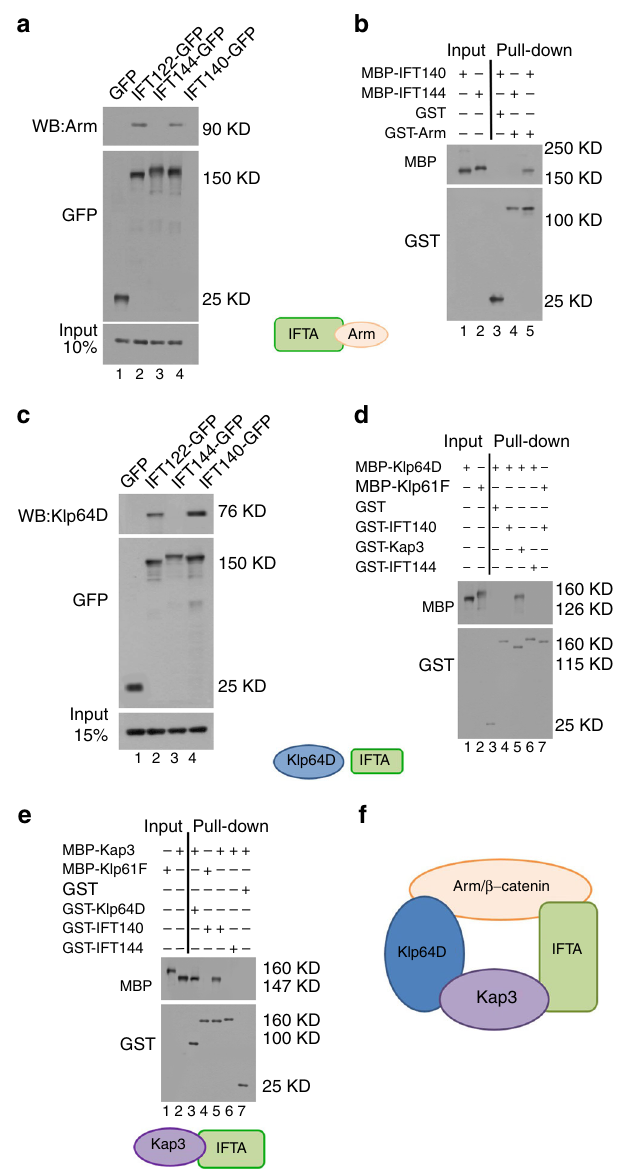
Fig. 3 Kinesin-2, IFT-A, and Arm/ β -catenin are physically associated. a , c Co-immunoprecipitation assay of IFT-A components with Klp64D or Arm from tub> IFT122GFP (lane 2) and tub > IFT140GFP (lane 4) or tub > IFT144 (as a negative control, lane 3) wing imaginal discs. Protein extracts from wing discs were immunoprecipitated (IPed) with anti-GFP. IPs and input (10 − 15% of wing disc lysates used in IP step) were analyzed by blotting with antibodies to Arm ( a ), or Klp64D ( c ). Note that IFT-A components (IFT122 and IFT140) associate with Arm/ β -catenin ( a ) and Klp64D ( c ). b Direct binding of IFT140 and Arm. Full-length IFT140 (lane 1: input 15%) was pulled down by GST-Arm (lane 5), IFT144 and GST alone are negative control (lanes 3, 4). d Klp64D is indirectly associated with IFT140. Full- length Klp64D (lane 1, 10% input) was not pulled down by GST (lane 3, negative control), or GST-IFT144 (lane 6, negative control), or GST-IFT140 (lane 4), but was pulled down by GST-Kap3 (lane 5; positive control). Full- length Klp61F (negative control; lane 2: 10% input) was not pulled down by GST-IFT140 (lane 7). e IFT140 directly binds to Kap3. Full-length Kap3 (lane 2: 10% input) was pulled down by GST-Klp64D (lane 3; positive control) and GST-IFT140 (lane 5), but not by GST-IFT144 or GST (lanes 6, 7; negative control) or full-length Klp61F (negative control; lane 1: 10% input; lane 4, pull-down assay). f The physical interaction model between Kinesin-2, IFT-A components, and Arm/ β